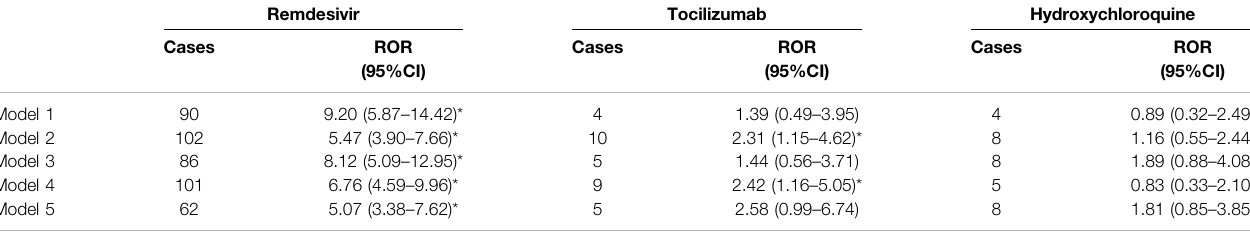
TABLE 3 | Sensitivity analyses of reporting risks for AKI upon the use of drugs prescribed for COVID-19 in